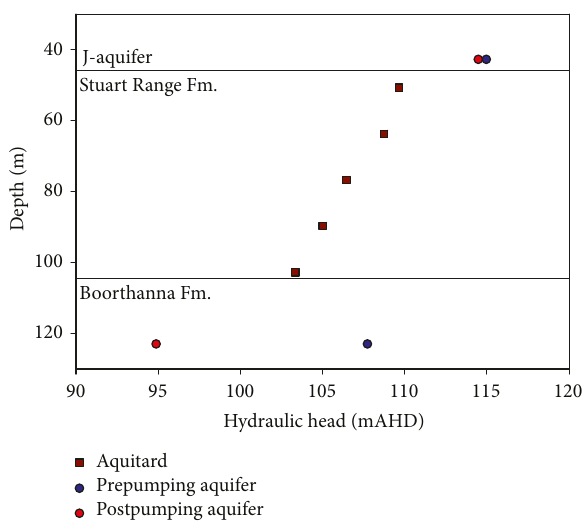
Figure 3: Hydraulic head in m AHD by the VWP installed throughout the aquitard and measured in nearby wells in the upper aquifer and lower